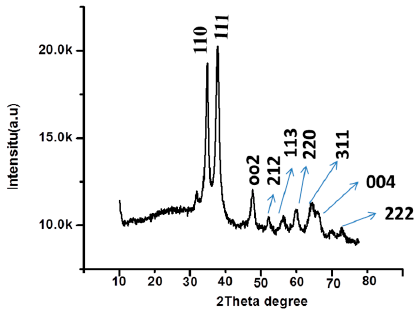
Figure 1. XRD spectrum of CuO nanostructures prepared in the presence of lysine as a soft template.